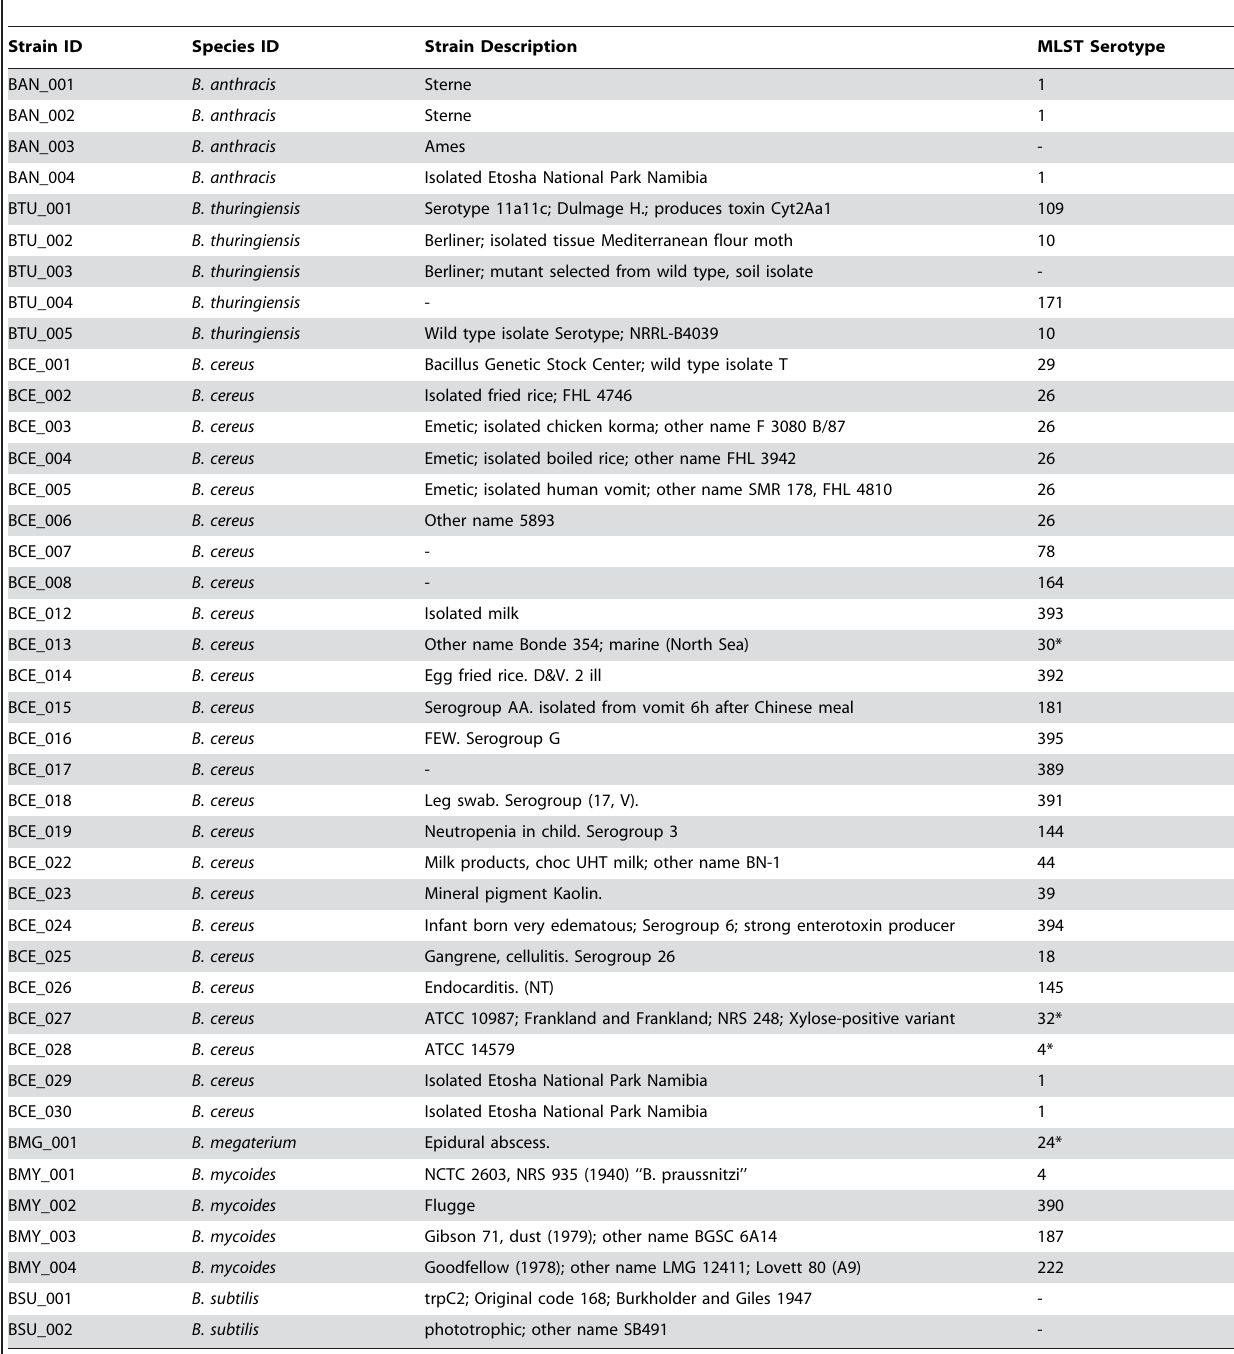
Table 1. Bacillus strains resequenced in this